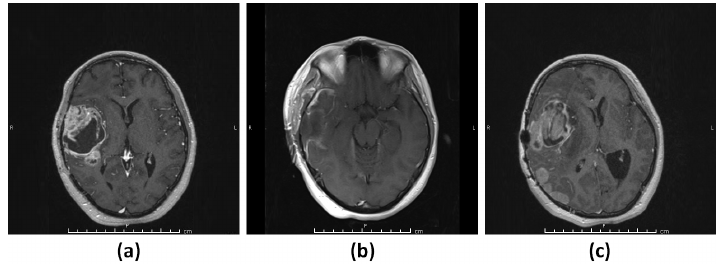
Figure 1. Patient 1 (G1). ( a ) T 1 -weighted MRI showing a contrast-enhancing lesion in the right frontotemporal region. ( b ) T 1 -weighted MRI showing gross total resection of the tumor. ( c ) T 1 -weighted MRI showing rapid recurrence of the tumor.